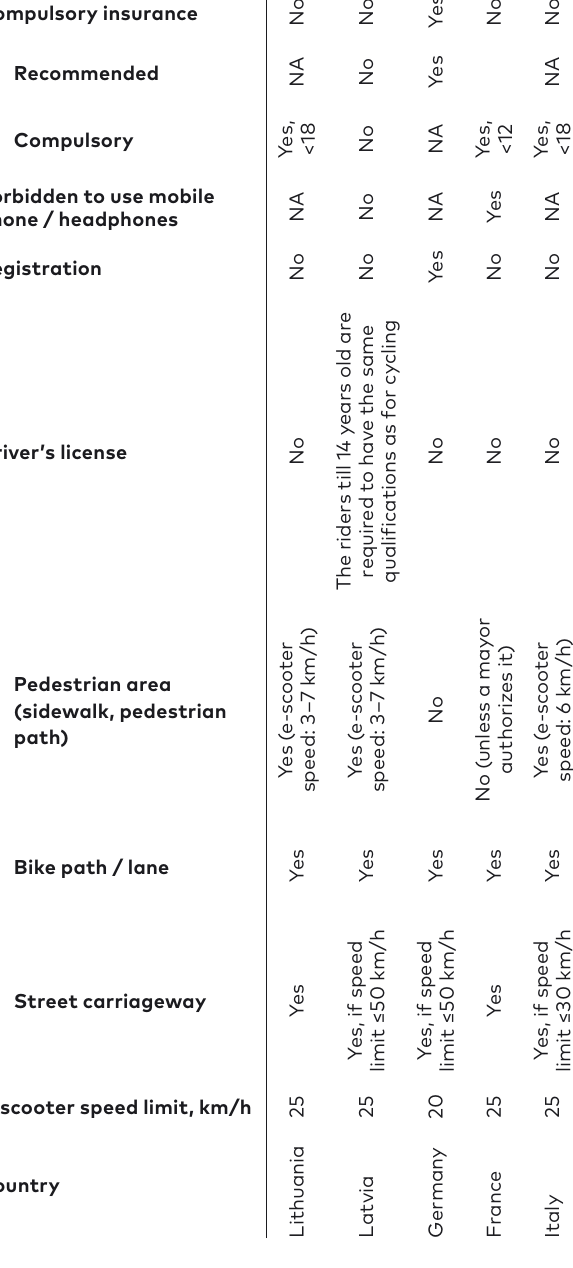
Table 1. E-scooter laws in